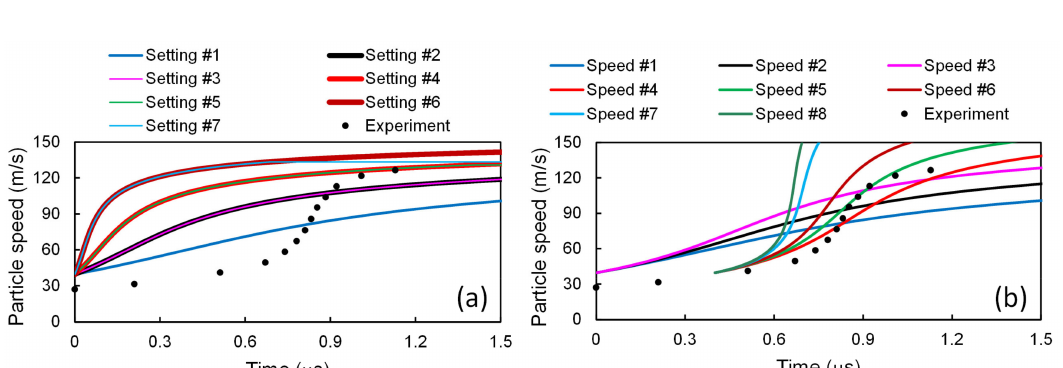
Figure 6. Particle speed profiles for 6061-T6 Al alloy at shock stress amplitude of 2.1 GPa, calculated with the model of Austin and McDowell [2], ( a ) with C = 5353 m/s, where setting #1 means α 0 = 1.0, β 0 = 0.1, setting #2 means α 0 = 0.9, β 0 = 0.1, setting #3 means α 0 = 0.9, β 0 = 0.2, setting #4 means α 0 = 0.8, β 0 = 0.1, setting #5 means α 0 = 0.8, β 0 = 0.2, setting #6 means α 0 = 0.7, β 0 = 0.1, setting #7 means α 0 = 0.7, β 0 = 0.2, and ( b ) with α 0 = 1.0, β 0 = 0.1, where speed #1 means C = 5353 m/s, speed #2 means C = 5383 m/s, speed #3 means C = 5407 m/s, speed #4 means C = 5437 m/s, speed #5 means C = 5457 m/s, speed #6 means C = 5477 m/s, speed #7 means C = 5519 m/s, speed #8 means C = 5535 m/s. The experimental results [43] have been presented for